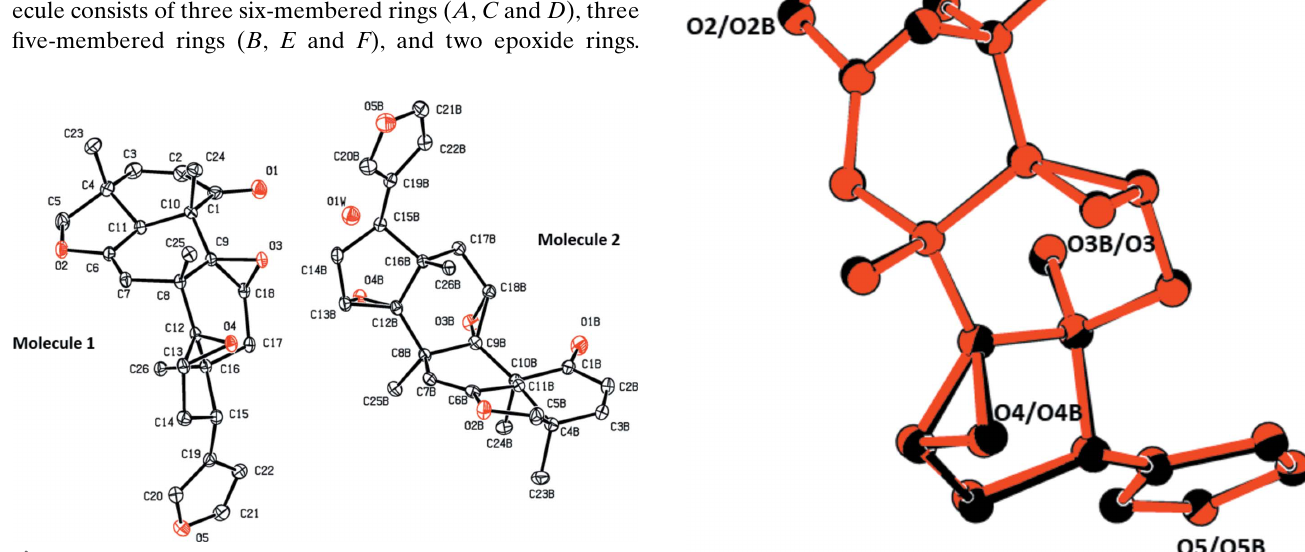
Figure 1 The molecular structure of the two independent molecules (1 and 2) of the title compound TS3 with the crystallographic labelling scheme. Displacement ellipsoids are drawn at the 50% probability level. H atoms have been omitted for